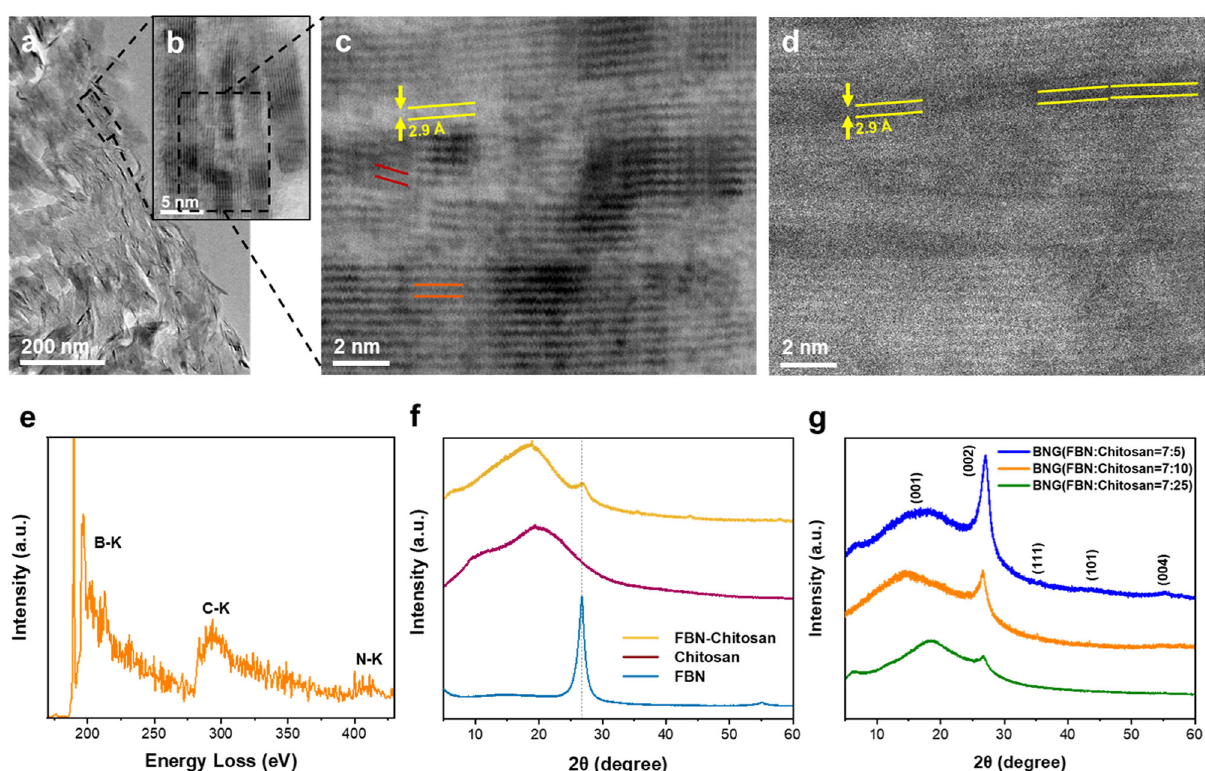
Fig. 3 | Analysis of the nanostructure of BNG membranes. a TEM image of the BNG membrane cross-section (FBN: chitosan = 7:10). b HRTEM image of the BNG membrane cross-section in the selected area shown in ( a ). c HRTEM image of the cross-section of the BNG membrane in the selected area shown in ( b ). The HRTEM image reveals the alternating stacking of BN and graphene sheets. Interlayer spa- cingsofgrapheneandBNsheetsareillustratedinredandorange,respectively,and